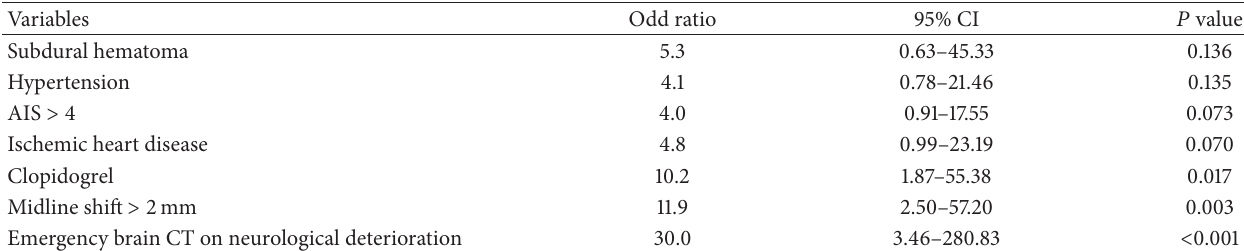
Table 3: Determination of odd ratio and 𝑃 value in neurosurgical treatment group in mild